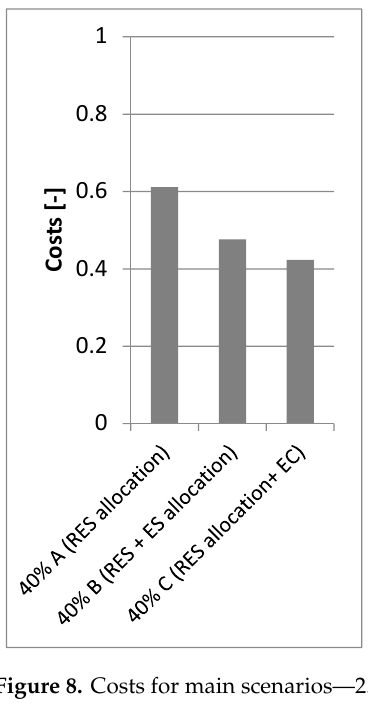
Figure 8. Costs for main scenarios—2.